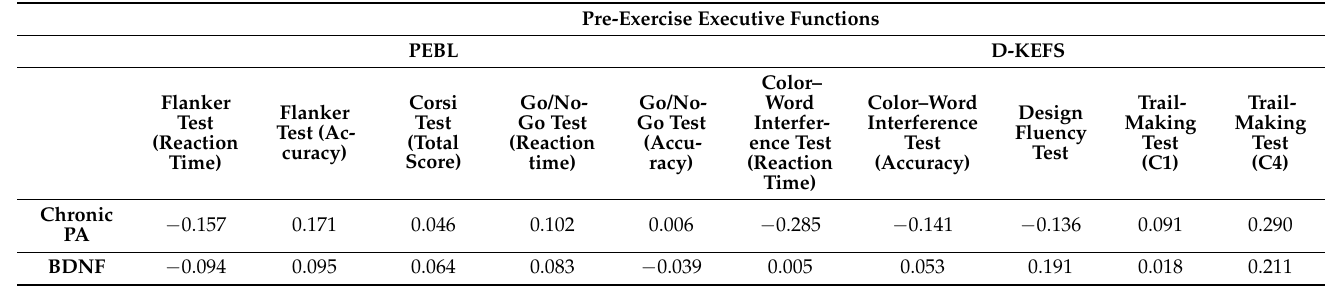
Table 2. Bivariate correlations among chronic PA, executive functions, and